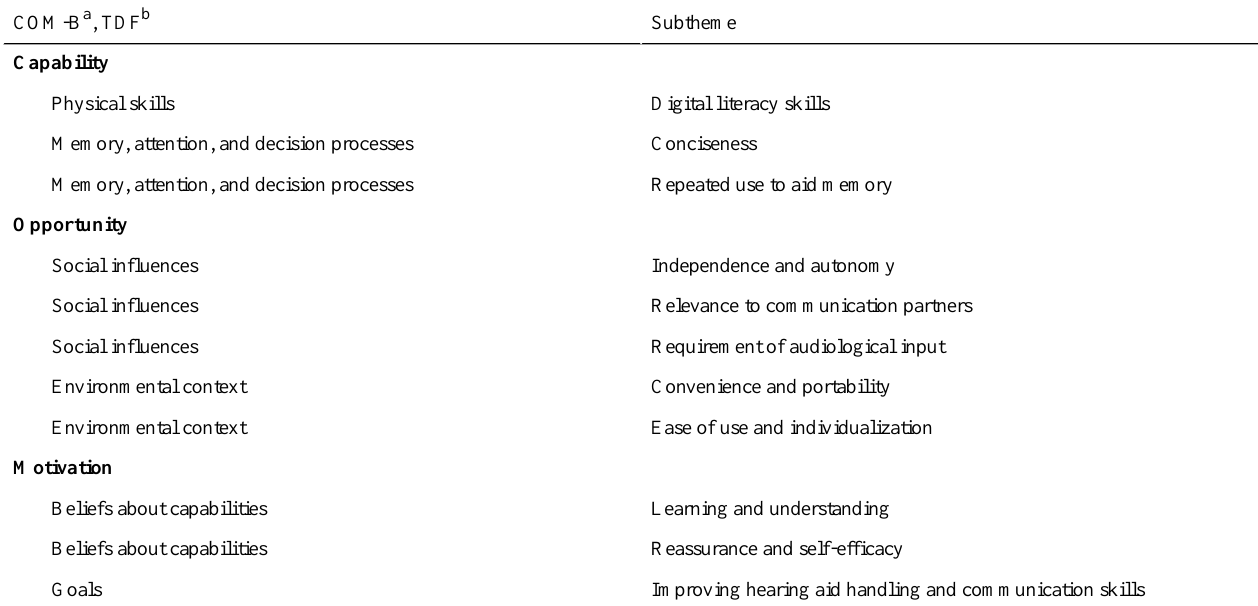
Table 3. A summary of subthemes generated in relation to the Capability, Opportunity, Motivation-Behavior model and theoretical domains